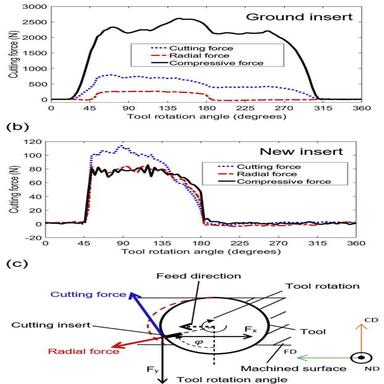
Plots of the forces during one tool rotation: (a) sample 8 in which a white layer was generated on the surface and (b) sample 4, where a surface with good SI was produced. (c) A schematic outlining the coordinate system showing cutting and radial forces with respect to the x and y forces measured by the dynamometer.